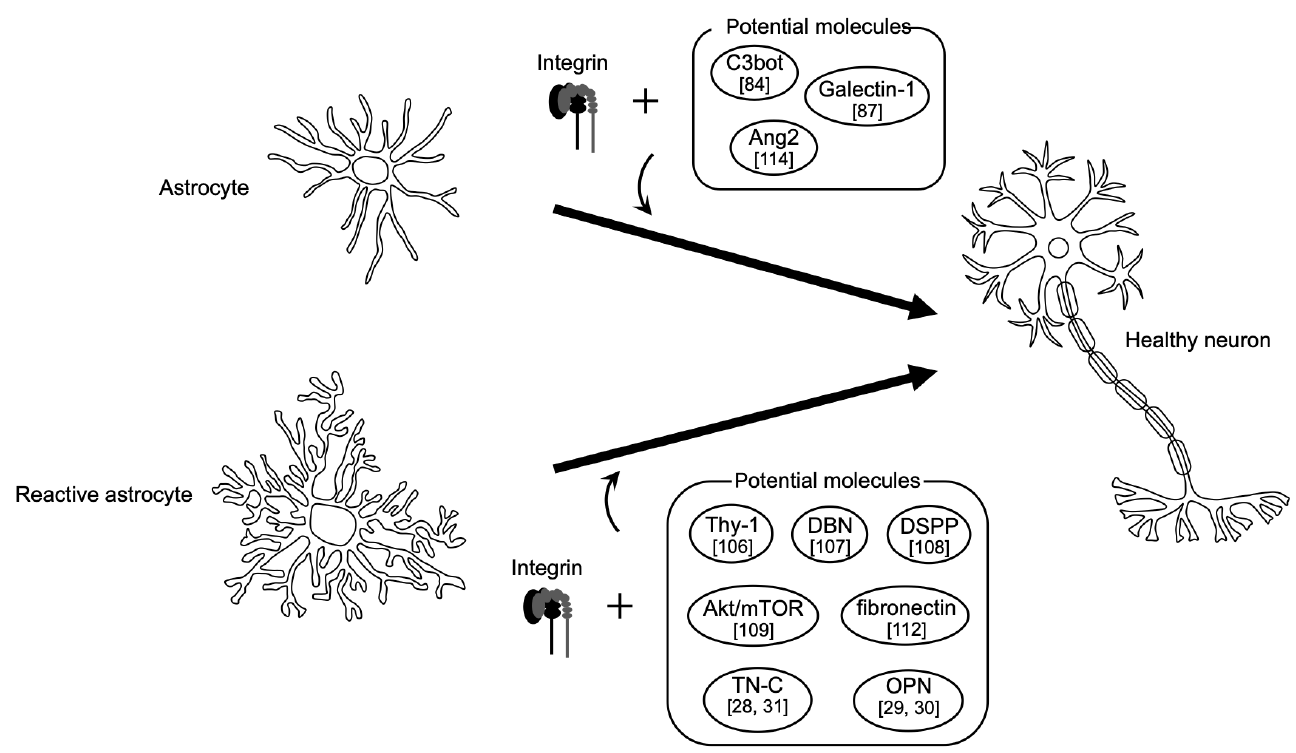
Figure 2. Involvement of integrins in CNS regeneration in collaboration with potential factors. Mod- ulation of integrins with potential factor(s) stated in the main text, and possibly also the environment, could convert astrocytes or reactive astrocytes to healthy neurons for induction of neuro-regeneration in the mammalian CNS. The number(s) in square brackets beside the factor names are the reference numbers cited in the main text [28 – 31,106 – 109,112].